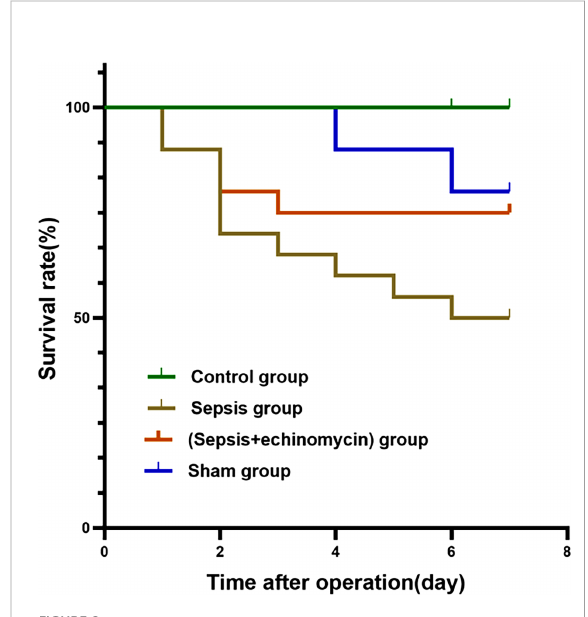
FIGURE 2 Kaplan-Meier survival curves for four groups of mice. Echinomycin improved survival rate in the fi rst 7 days after